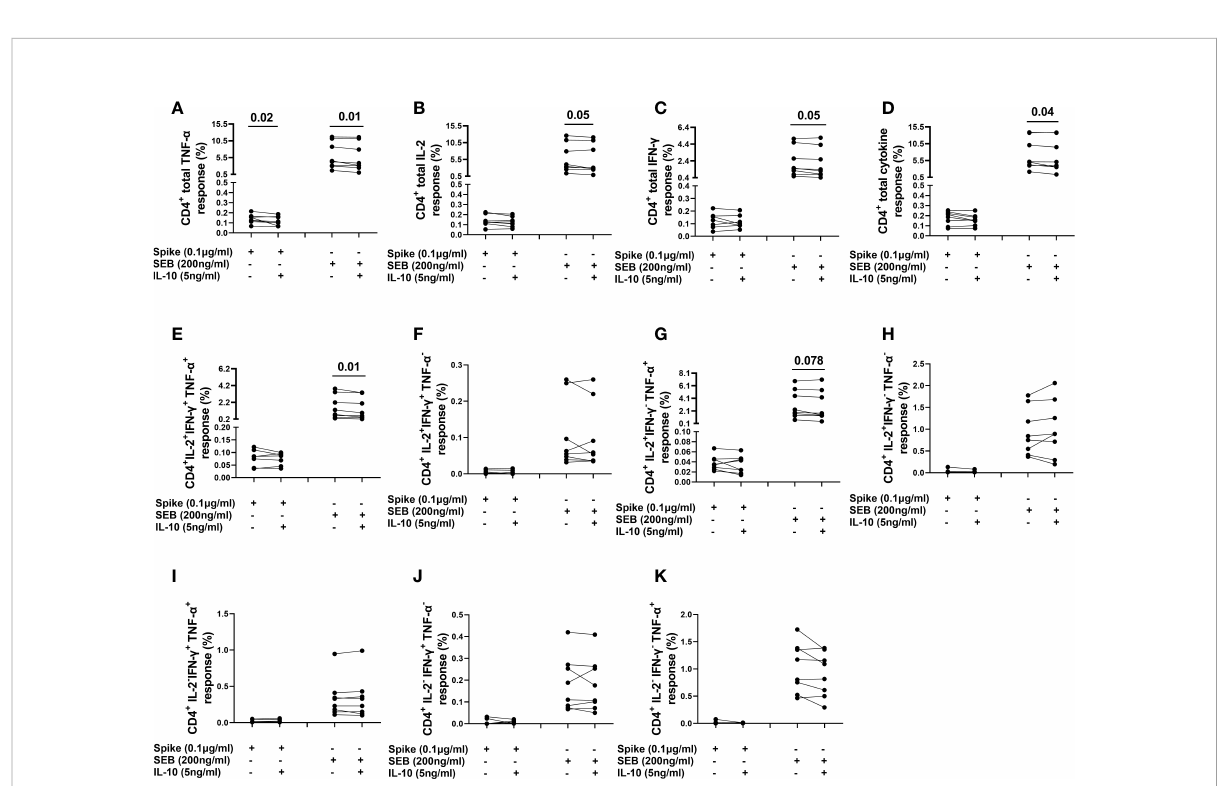
FIGURE 7 Evaluation of the effect of IL-10 on CD4 + T-cells populations in NO COVID-19-Vaccinated Controls of study population “ B ” , by fl ow cytometry (n=8). (A) percentage of CD4 + TNF- a + cells; (B) percentage of CD4 + IL-2 + cells; (C) percentage of CD4 + IFN- g + cells; (D) percentage of total (Th1) cytokine response of CD4 + cells; (E) percentage of CD4 + IL-2 + IFN- g + TNF- a + subset; (F) percentage of CD4 + IL-2 + IFN- g + TNF- a - subset; (G) percentage of CD4 + IL-2 + IFN- g - TNF- a + subset; (H) percentage of CD4 + IL-2 + IFN- g - TNF- a - subset; (I) percentage of CD4 + IL-2 + IFN- g + TNF- a - subset CD4 + IL-2 - IFN- g + TNF- a + subset; (J) percentage of CD4 + IL-2 - IFN- g + TNF- a - subset; (K) percentage of CD4 + IL-2 - IFN- g - TNF- a +